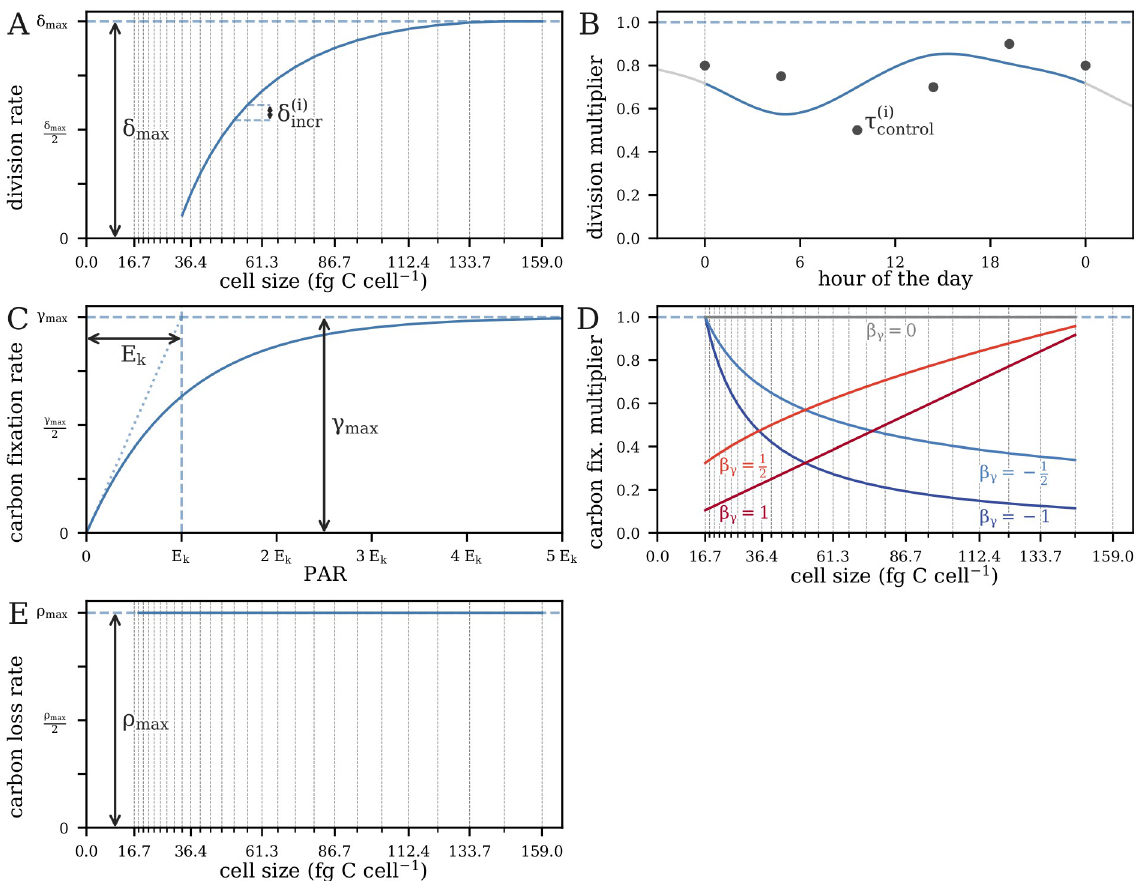
Fig 7. Functional forms of model rate parameter dependencies on size, light, and time (compare Table 1). (A) Examples of a monotonic relationship between size and division rate, and (B) a time-dependent relationship between the time of day and division rate. (C) The shape the light-dependent carbon fixation rate and examples of (D) power-law size-dependence of carbon fixations for 5 values of the parameter β γ ; the “basic” parameterization is identical to β γ = 0. (E) The “basic” size-dependence of carbon loss. Vertical lines in panels with size-dependence denote the center of each size class. Examples of “free” carbon fixation or carbon loss parameterizations are not shown.